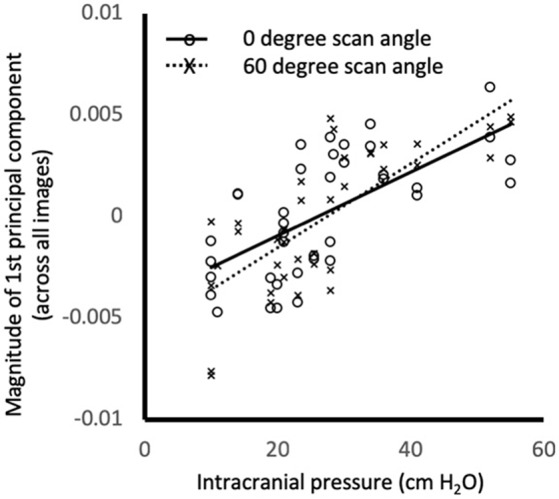
Relationship between intracranial pressure (measured as opening pressure during lumbar puncture) and magnitude of the first principal component of shape for the all images. Markers show the values for individual images at 0° (o) and 60° (x) using distance-14 semi-landmarks. Lines are linear regression fits to 0° (solid) and 60° (dashed). PC1all magnitude was similar between left and right eyes, but differed across scan angles accounting for ICP (p < 0.005, rmANOVA). Similar relationships were observed for different scan angles and semi-landmark placement strategies (not shown).